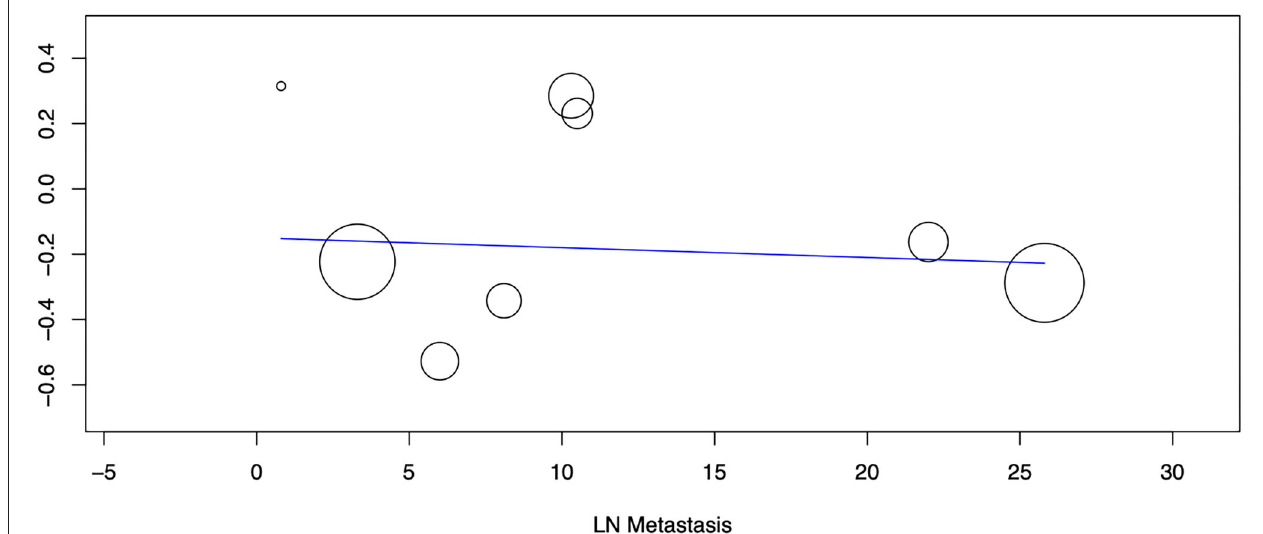
FIGURE 3 | Meta-regression of the influence of percentage of lymph node metastasis (X-axis) on the pooled effect size of OS (Y-axis). Individual studies are represented by circles.